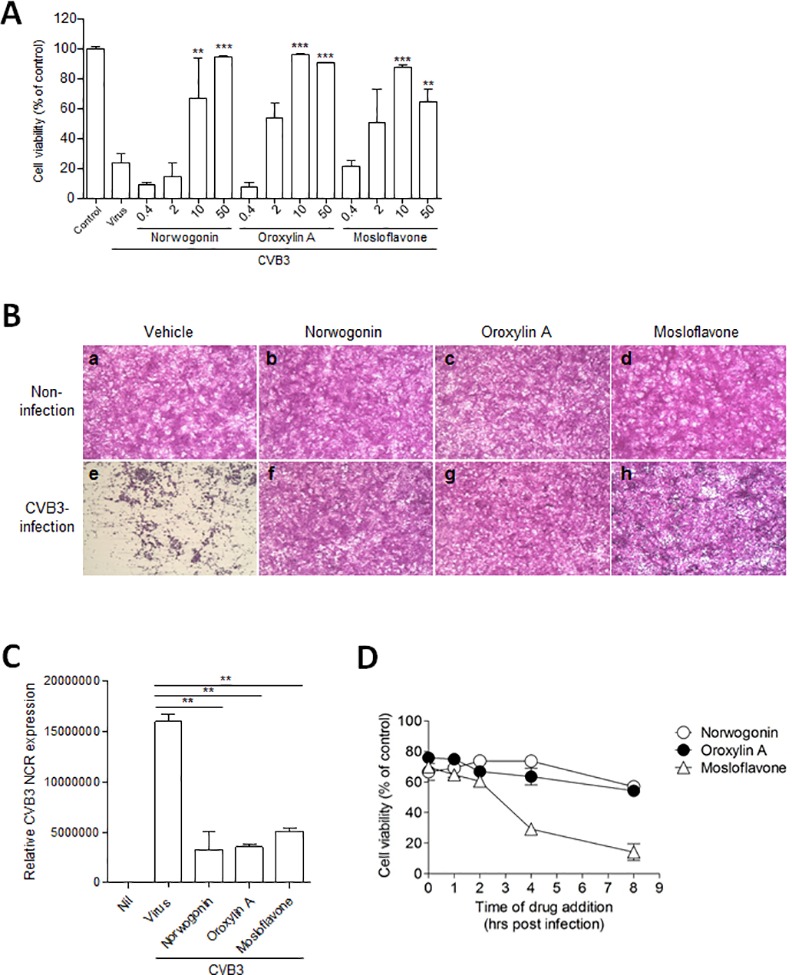
The antiviral activities of norwogonin, oroxylin A, and mosloflavone against CVB3 in vitro.(A) Antiviral activities of norwogonin, oroxylin A, and mosloflavone against CVB3 in Vero cells were measured by SRB assay. The indicated concentration of norwogonin, oroxylin A, and mosloflavone, ranging from 0.4–50 μg/ml, were added to Vero cells infected with the CCID50 titer of CVB3. Cells were cultured for 48 h and the antiviral activity was determined by CPE reduction assay. Absorbance values are presented as means ± SD from 3 independent experiments each carried out in triplicate. **P<0.001; ***P<0.0001 using one-way ANOVA with Tukey’s post hoc test. (B) The effects of norwogonin, oroxylin A, and mosloflavone on CVB3–induced CPE using SRB assay. The virus-infected cells were treated with norwogonin, oroxylin A, and mosloflavone at 50 μg/mL. After incubation at 37°C in 5% CO2 for 48 h, the morphologies of cells were photographed under a microscope. (B-a) Non-infected cells; (B-b) non-infected cells treated with norwogonin; (B-c) non-infected cells treated with oroxylin A; (B-d) non-infected cells treated with mosloflavone; (B-e) CVB3-infected cells; (B-f) CVB3-infected cells treated with norwogonin; (B-g) CVB3-infected cells treated with oroxylin A; (B-h) CVB3-infected cells treated with mosloflavone; (C) Relative CVB3 gene expression in control, CVB3-infected, and 10 μg/ml norwogonin-, oroxylin A-, and mosloflavone-treated cells by real-time PCR. **P<0.001 using one-way ANOVA with Tukey’s post hoc test. (D) TOA effects of norwogonin, oroxylin A, and mosloflavone on CVB3 replication in Vero cells. 30 μg/mL of each compound was added either during (0 h), or after (1, 2, 4, or 8 h) virus infection. After 2 days, inhibition was evaluated by the SRB method and expressed as the inhibition rate. Percentage values represent the mean ± SD of 3 independent experiments.